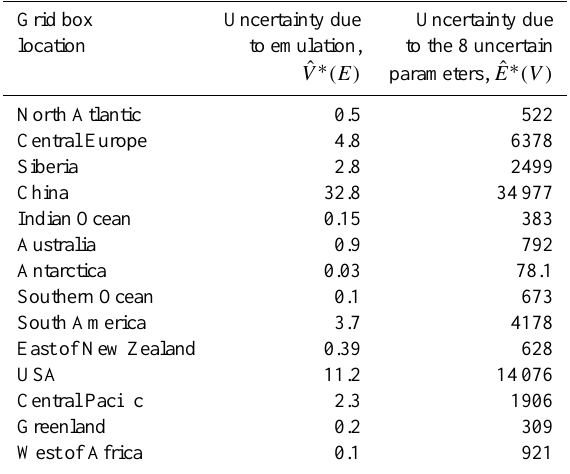
Table 2. The uncertainty around the emulator estimated CCN due to emulation and due to the uncertain parameters at 14 grid boxes shown in Fig.